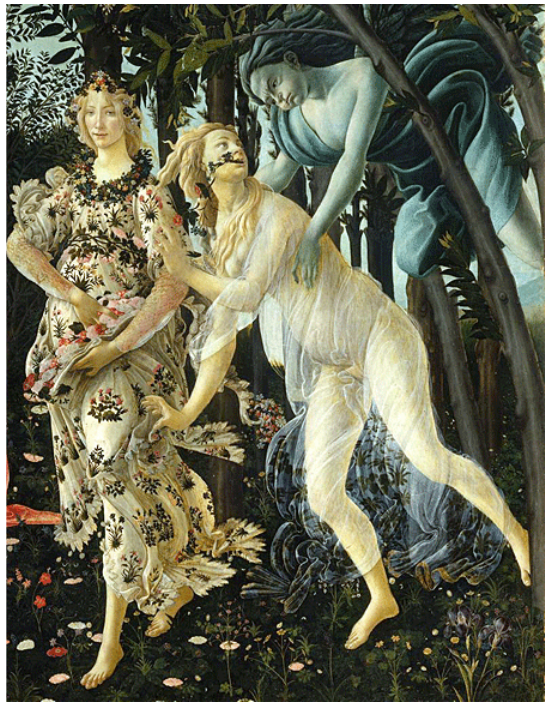
Figure 3. The detail focuses on the aggressive Zephyrus (whose wings are stuck in the branches of the tree) and fearful Chloris, who is literally pushed by him onto the scene. https://artstor.wordpress.com/2013/03/20/